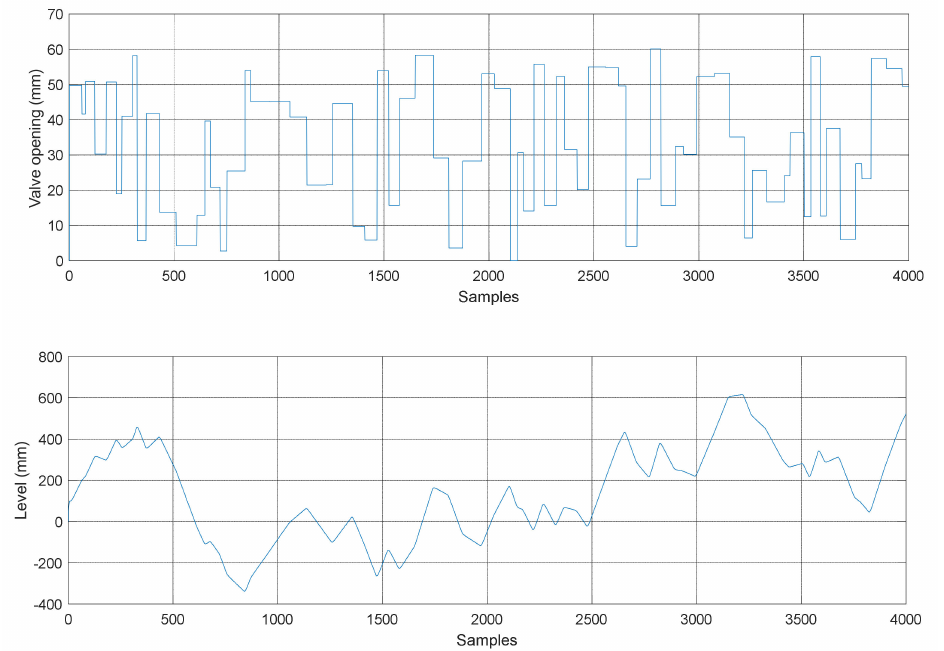
Figure 12. Input and output data used for identification of the